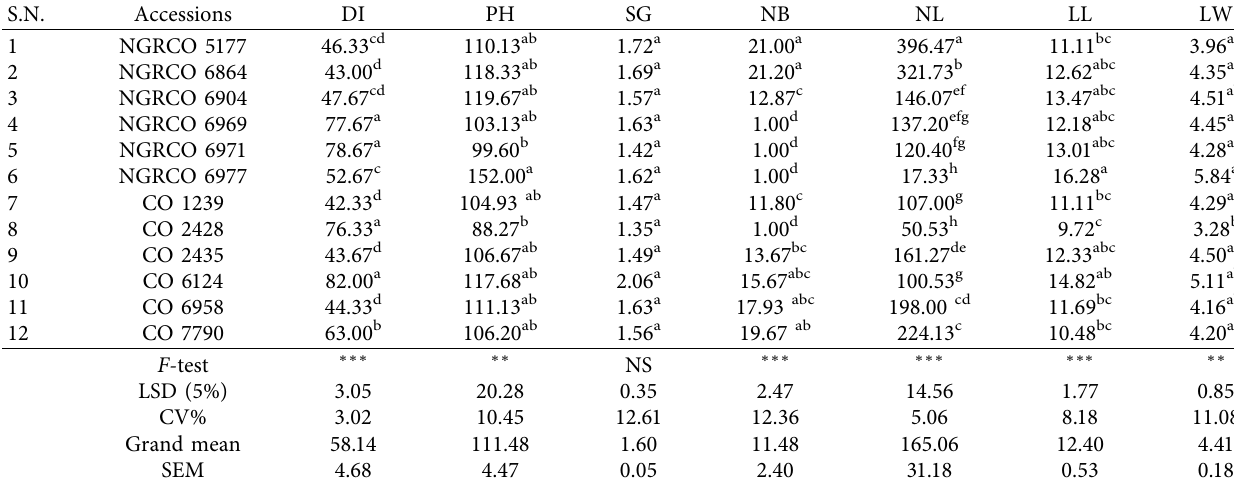
Table 3: Mean performance of twelve amaranth accessions for phenological and vegetative traits in Lamjung, in 2021.